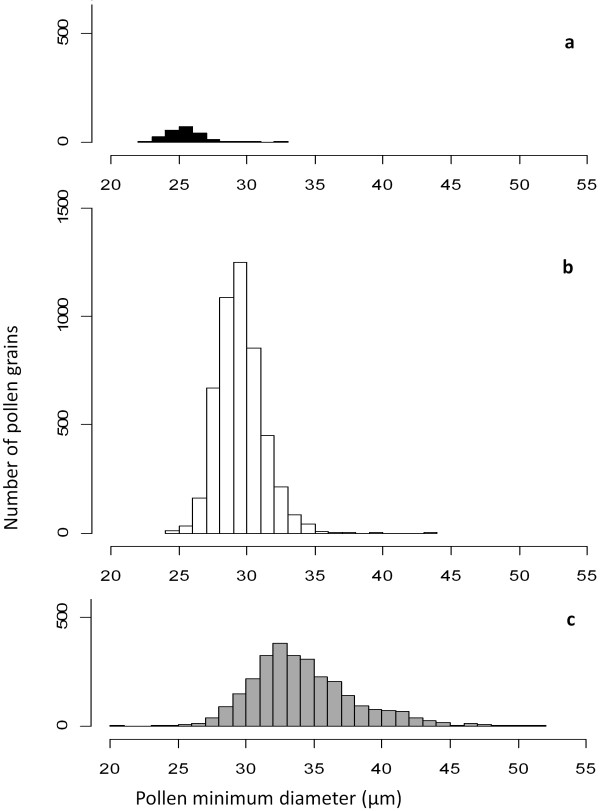
Viable pollen size distributions and ploidy in parental lines and cultivars of Brassica. Pollen viability was estimated using fluorescein diacetate stain and pollen diameter was measured under the microscope in μm (viable pollen only), with the expectation that pollen size would be proportional to DNA content of the pollen grain. a) B. rapa (2n = 2x = AA) pollen, expected pollen ploidy n = x = A; b) B. juncea (2n = 4x = AABB), B. napus (2n = 4x = AACC) and B. carinata (2n = 4x = BBCC) pollen, expected pollen ploidy n = 2x = AB, AC or BC respectively; c) 2n = 4x interspecific hybrid B. juncea × B. napus (AABC), B. juncea × B. carinata (BBAC) and B. napus × B. carinata (CCAB) pollen, expected ploidy for reduced pollen n = x - 3x: A-ABC, B-ABC and C-ABC respectively. The bias of the hybrid pollen size distribution to the right suggests unreduced gamete production (ploidy 4x and above) as well as a viability advantage of higher DNA contents (mean of distribution > 2x, expected ploidy distribution x - 3x).